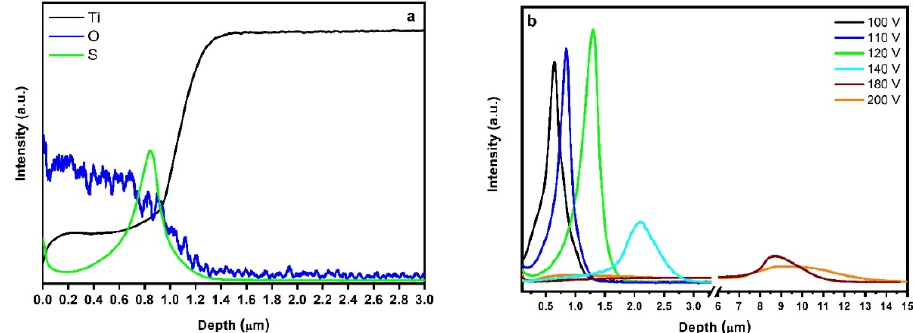
Figure 4. GD-OES in-depth profile of TiO 2 film ( a ) and sulfur peak as a function of film depth ( b ).